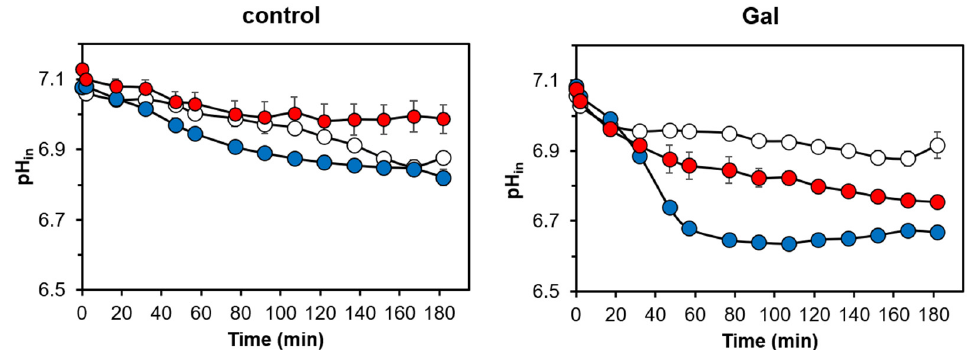
Figure 3. The absence of Nha1 decreases the intracellular pH drop caused by Ppz1 overexpression. Time course of intracellular pH changes in strains BY4741 (wild-type; white), ZCZ01 ( GAL1 : PPZ1 ; blue), and ZCZ06 ( GAL1 : PPZ1 nha1 ∆ ; red) expressing pHluorin and grown in YNB MP plus 2% Raff. Galactose (2% final concentration; right panel) or water (control; left panel) were added at time 0. Data represent the mean ± SEM from at least 5 independent experiments (with four technical replicates each). Statistics for this figure are offered as Supplementary Material (Table S1).